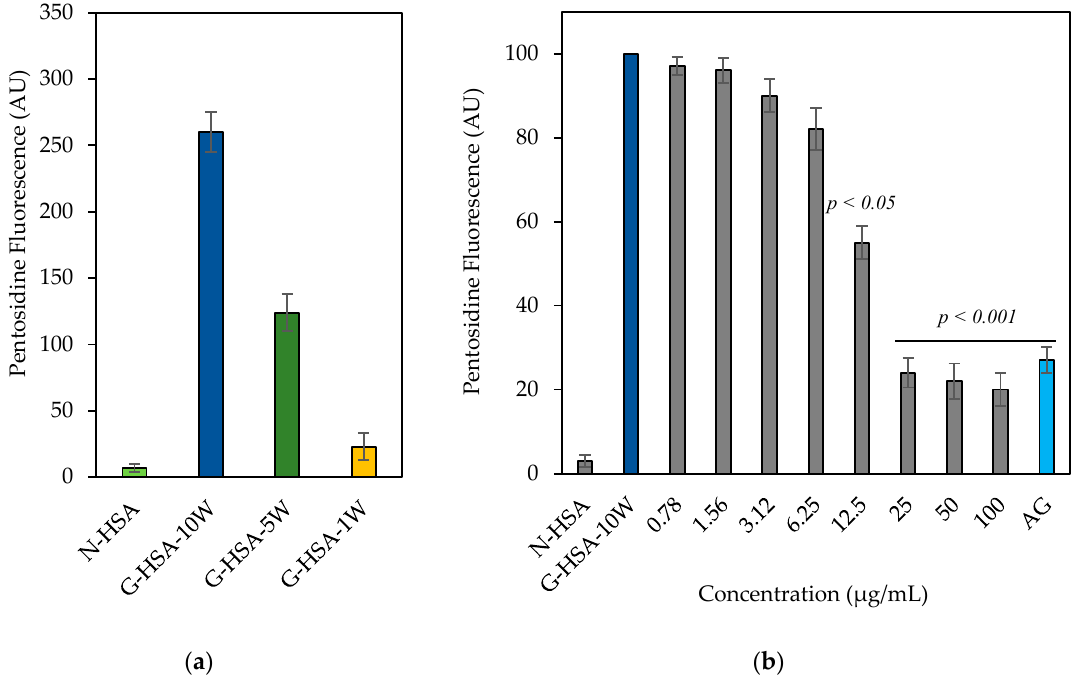
Figure 5. AGE molecule pentosidine specific fluorescence was recorded for non-glycated and glycated HSA samples ( a ). Effect of garlic extract on the formation of AGEs (pentosidine) during glycation of HSA (10 weeks) with different concentrations (0.78–100 µg/mL) of garlic ( b ). Data presented as mean ± SD values. t test was adopted for comparison between non-glycated vs. glycated HSA samples and significance was calculated.